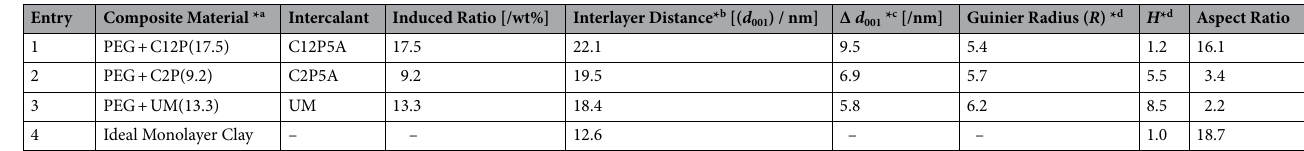
Table 1. PXRD data and small-angle X-ray scattering (SAXS) Guinier-plot data for clays in PEG. * a Clay additive condition is similar at 5 wt%; * b Interlayer distance of modified clays obtained by PXRD; *